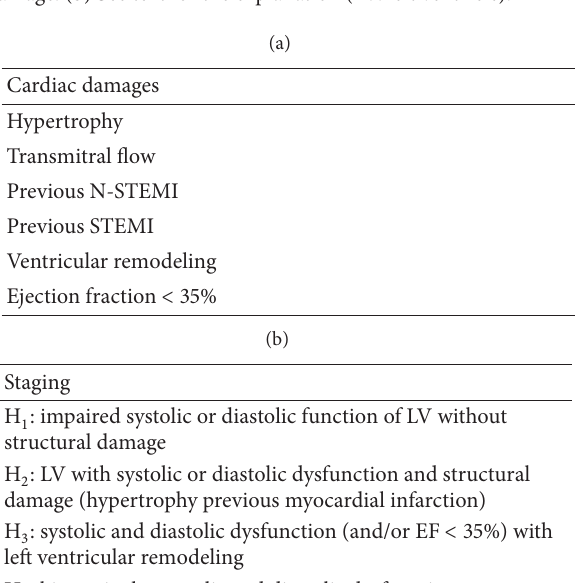
Table 1: (a) The parameters considered in the staging of the heart damage. (b) See text for the explanation (LV: left